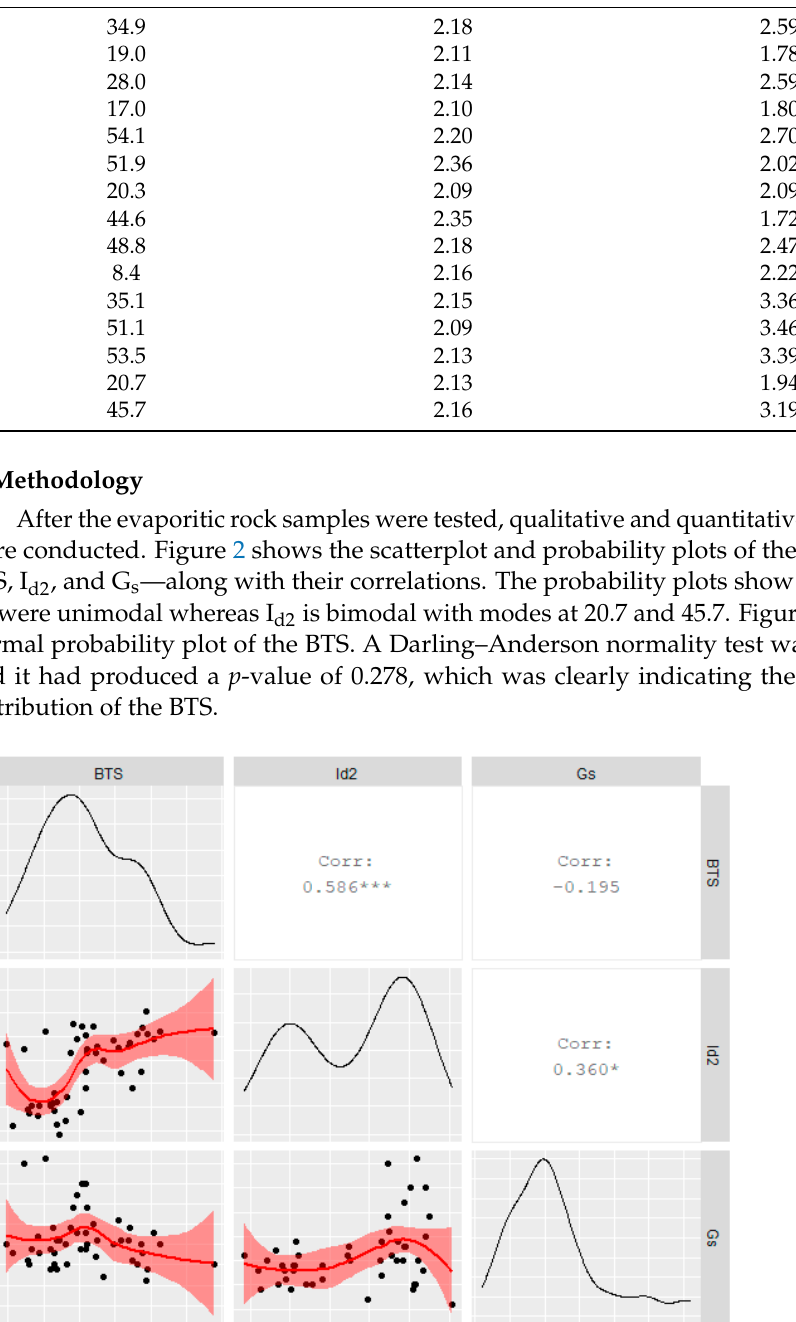
Table 1. Partial data used in the study.